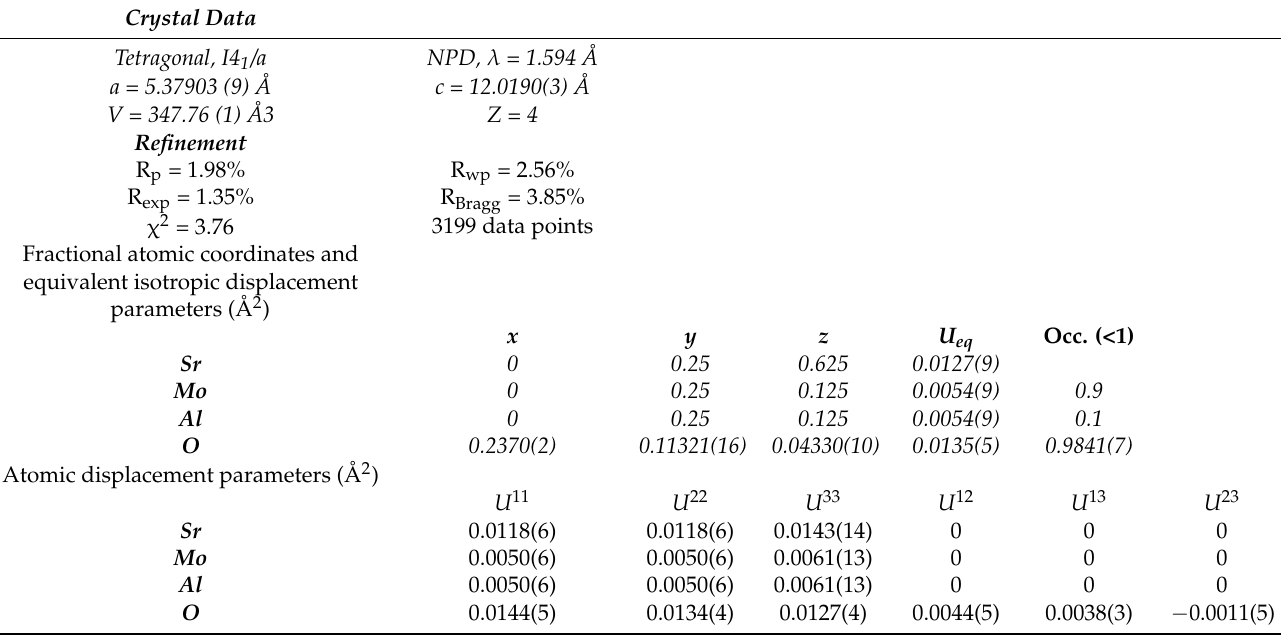
Figure 8. ( a ) Rietveld plot after the structural refinement from NPD data of the oxidation product yielding SrMo 0.9 Al 0.1 O 3.66 scheelite. Observed (crosses), calculated (full line), and difference (at the bottom) NPD profiles in the tetragonal I4/ a space group. The vertical markers indicate the allowed Bragg reflections. ( b ) View of the scheelite crystal structure, after the full anisotropic refinement of the displacement factors. Table 3. Structural parameters of SrMo 0.9 Al 0.1 O 3.67 scheelite after the Rietveld refinement from NPD data.